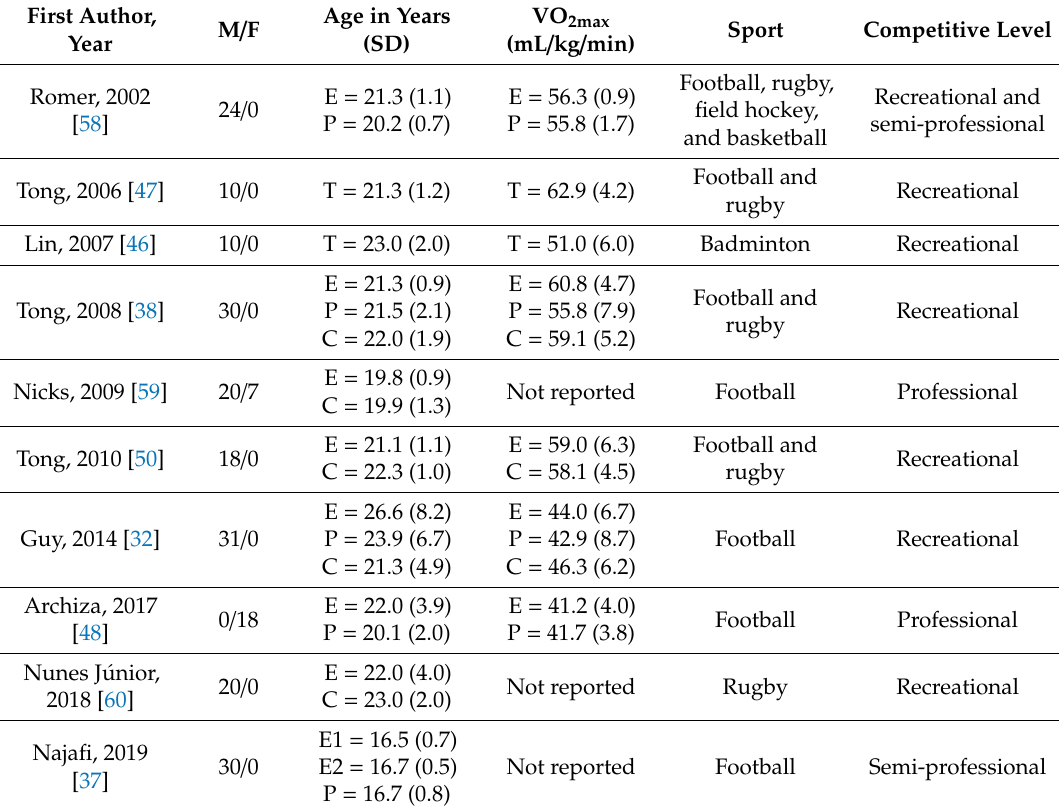
Table 3. Characteristics of participants